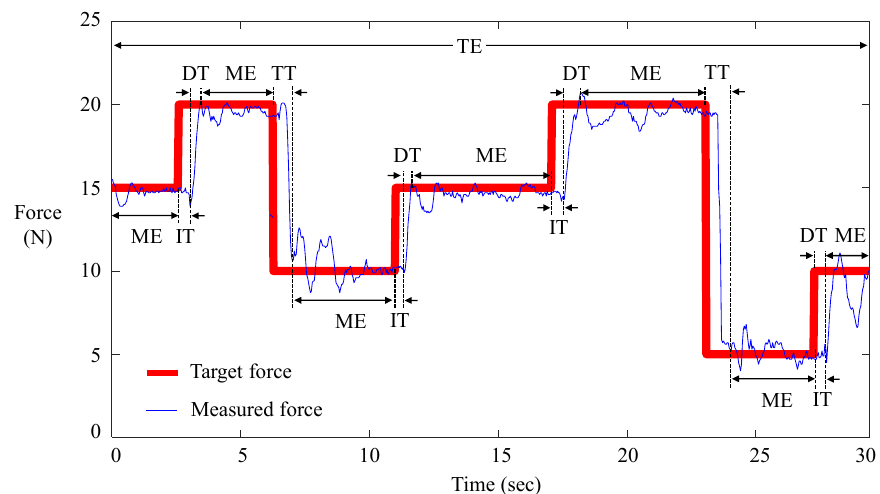
Figure 2. Illustration of force control measures (IT: initiation time, DT: development time, ME: maintenance error, TT: termination time, TE: tracking error).